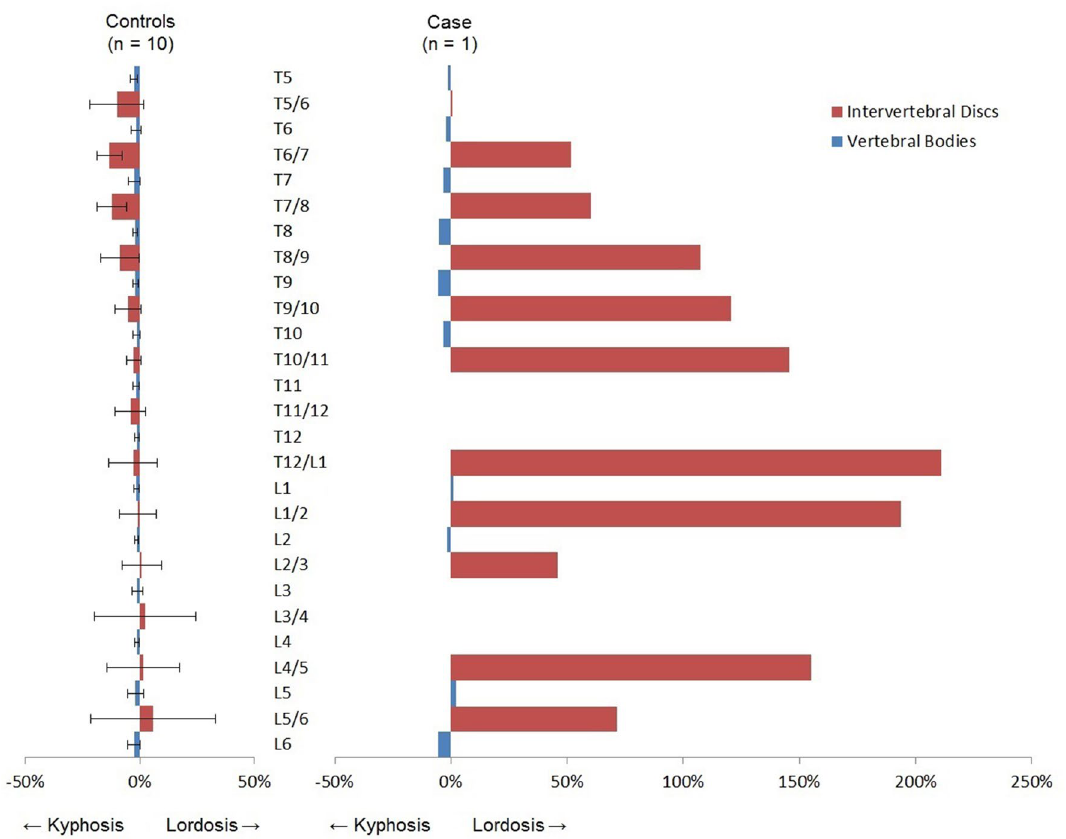
Figure 6. The mean anterior–posterior length discrepancy (AP%) with the standard deviation is shown for the intervertebral discs in red and the vertebral bodies in blue, for both the non-scoliotic controls and the whale with scoliosis. Endplates severely affected by trauma (L3/L4) and wedging (T11/T12) were excluded due to impossibility of proper CT-scan analysis. Positive AP% indicates a larger anterior length than posterior